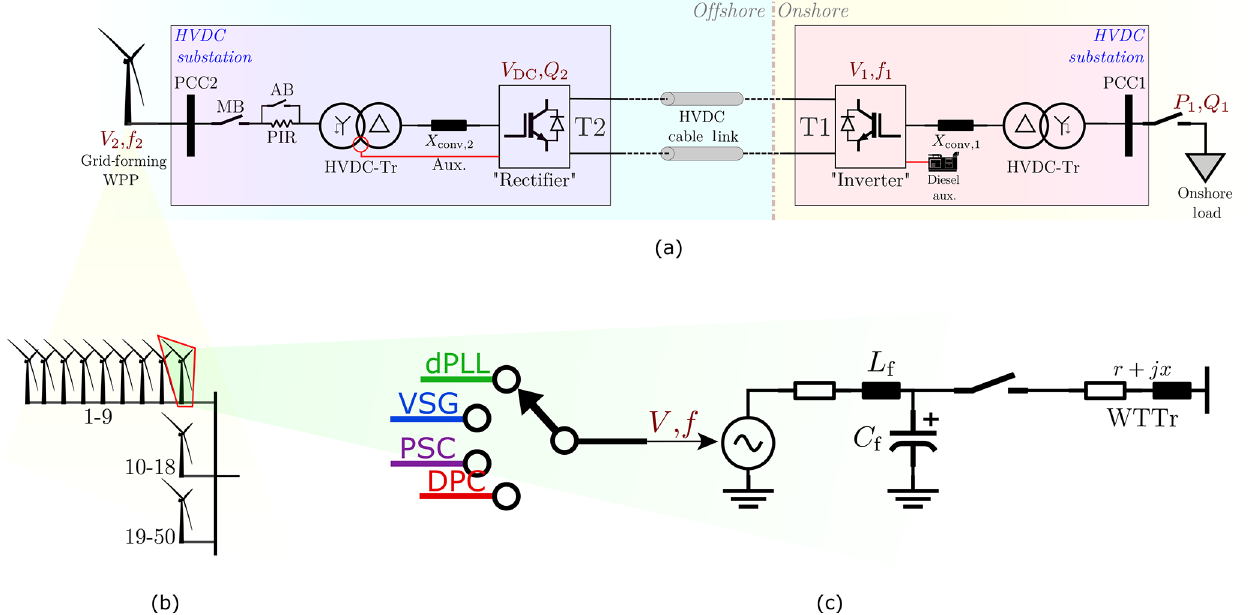
Figure 3. Schematic of the implemented PSCAD model of the system under study. This figure shows (a) the two-terminal HVDC link, with GFL offshore MMC and GFM onshore MMC, (b) the partial aggregation used to model the OWPP, and (c) the average model of the GFM WT-GSC implemented with four different control strategies operating in islanded